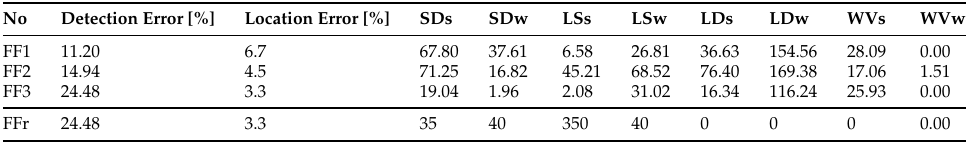
Figure 11. Result of the optimization process. Red asterisks refer to results of all individuals from the final population. Pareto front is denoted as circles. Three selected optimization results are denoted with ‘FF1’ to ‘FF3’ symbols. Table 2. Results of optimization for the Monit-POD